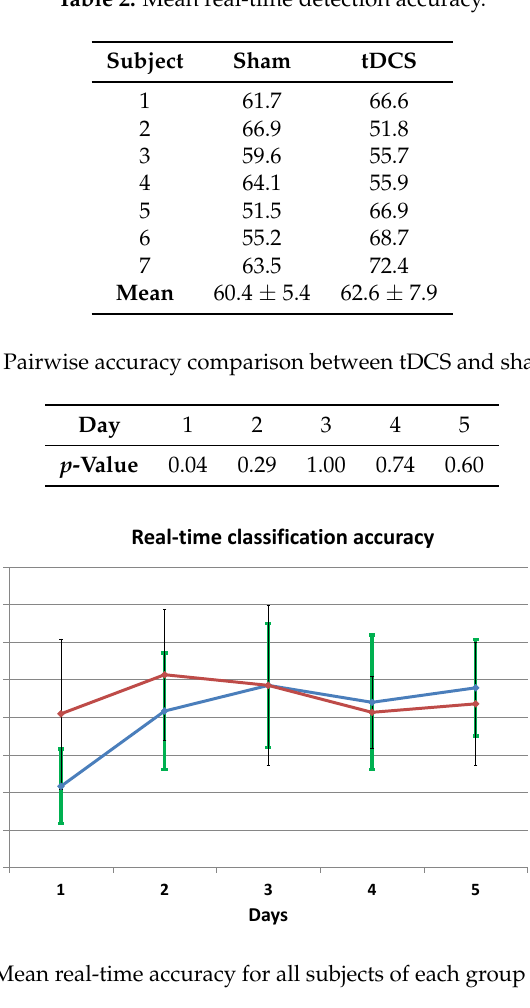
Table 2. Mean real-time detection accuracy.